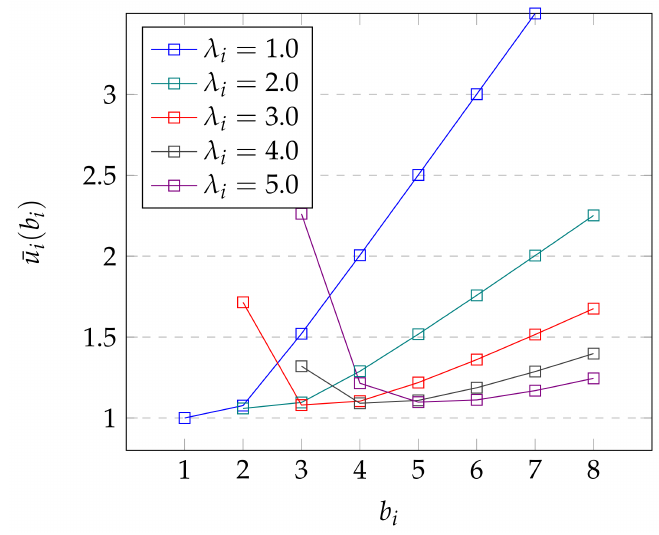
Figure 4. Average sojourn times in the node S i for µ i =